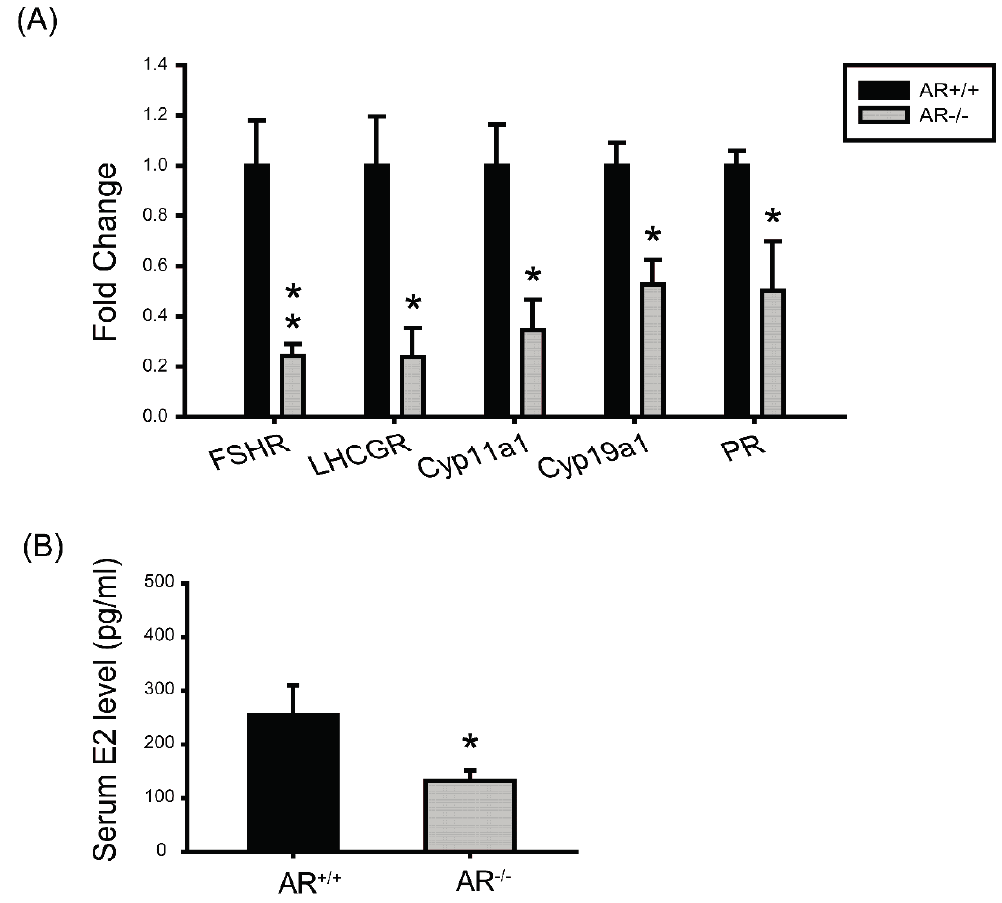
Figure 7. Molecular changes in granulosa cells of AR − / − mice and the effect of AR deficiency on serum estradiol (E2) levels. ( A ) The mRNA levels of genes that are important in granulosa cell differentiation during folliculogenesis and luteinization. At least three experiments were performed and data are presented as the mean ± SEM ( n = 4 mice per genotype) of the fold changes; ( B ) Serum E2 level was measured by ELISA. ( n = 4 mice per genotype). Data was expressed as the mean ± SEM. * p < 0.05, ** p < 0.01. FSHR: FSH receptor;